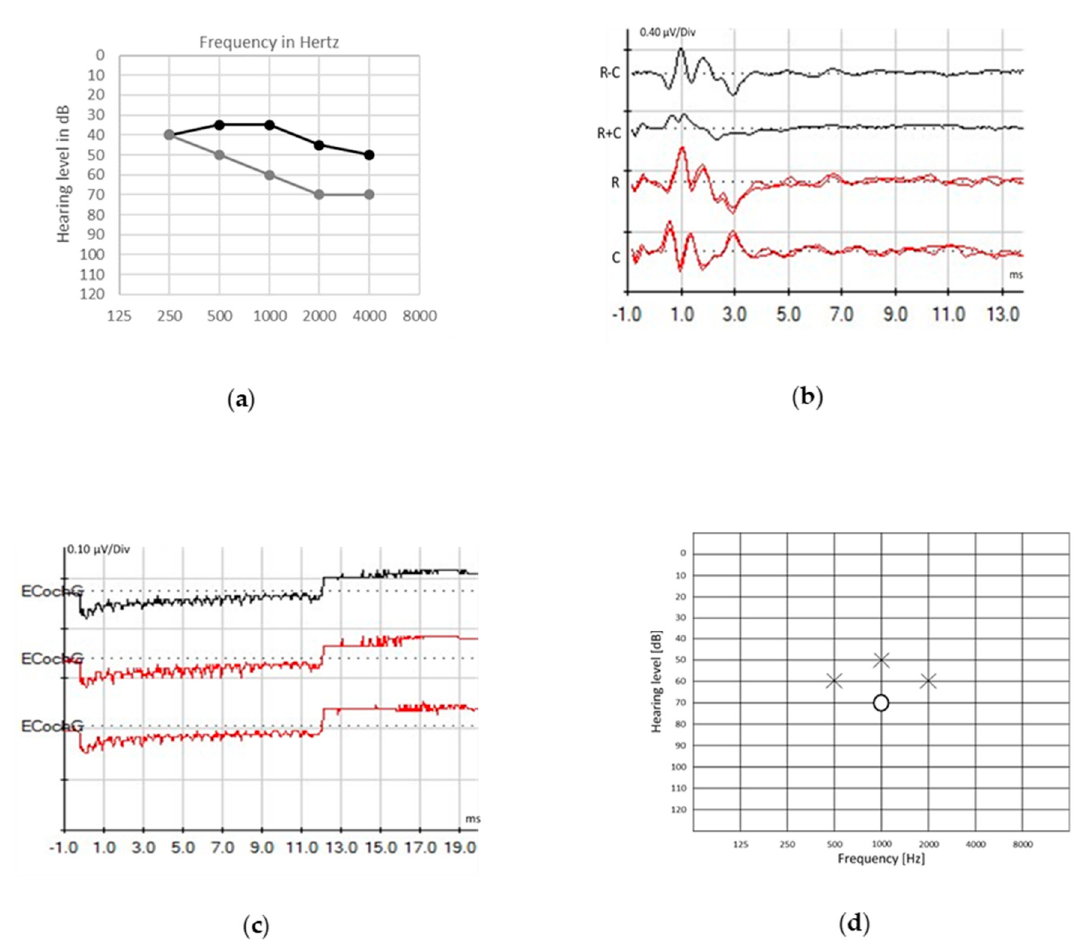
Figure 1. Audiological assessment in a 5-year-old child with auditory neuropathy spectrum disorder (ANSD) caused by neonatal hypoxia. Poor unaided pure-tone perception ( a , gray line) was restored with hearing aids (( a ), black line). Panel ( b ) displays auditory brainstem responses (ABRs) evoked by clicks presented in rarefaction (R) and condensation (C) polarities and the subtraction and summation of R and C (R − C and R + C, respectively), showing detectable cochlear microphonic (CM) and absence of waves V. Electrocochleography (ECochG) recorded through a transtympanic electrode on the promontory wall using 1000 Hz tone burst presented in alternated R and C polarities at a rate of 14.3 s ( c ) shows a large summating potential (SP). Auditory steady-state responses (ASSRs) thresholds ( d ) are present in the left (X) more than in the right (O) ear.